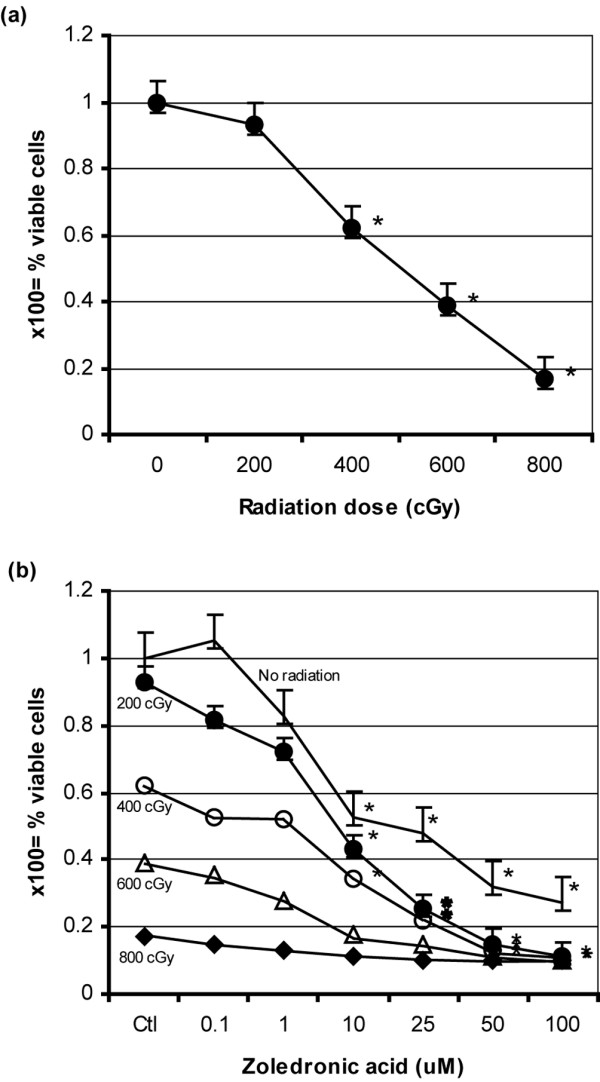
Radiation dose effect on MCF-7 cells. (a) MCF 7 cells treated with radiation alone. (b) The cytotoxic effect of radiation on MCF-7 cells increased steadily after incubating the cells with higher zoledronic acid concentrations. Ctl, control.